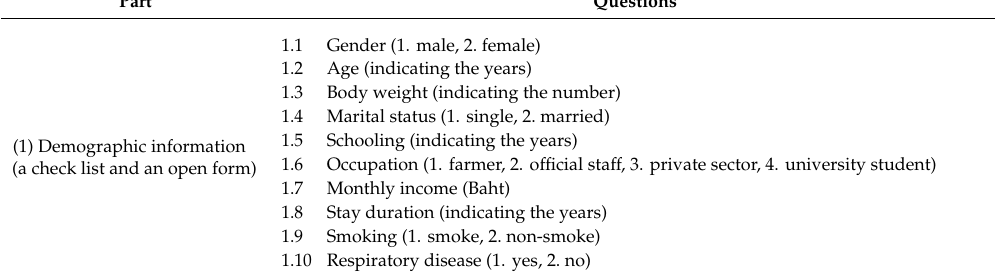
Table 1. The questions in the questionnaire used to ask the